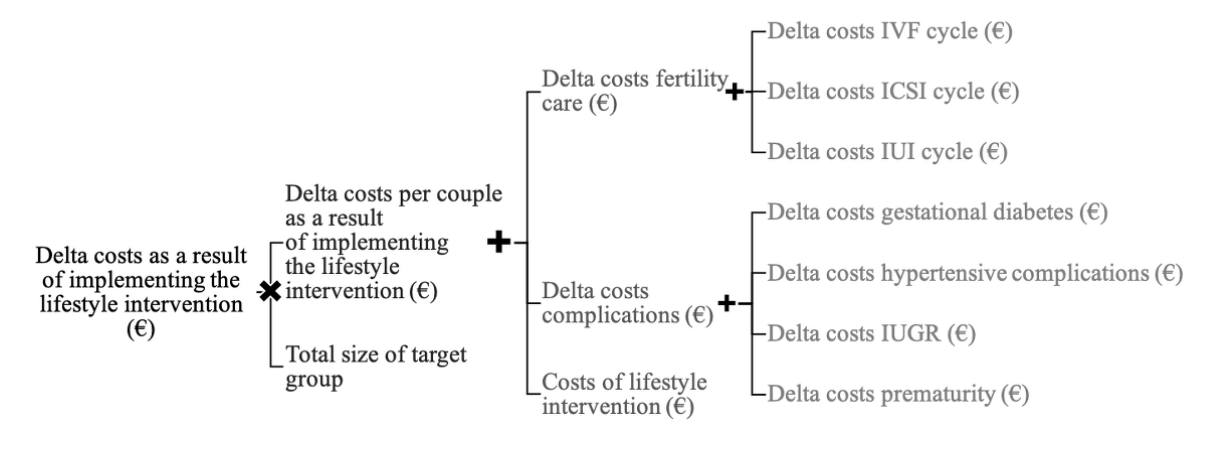
Figure 1. General structure of the cost-effectiveness model for each lifestyle intervention. IUGR: intrauterine growth restriction; IUI: intrauterine insemination; IVF: in vitro fertilization; ICSI: intracytoplasmic sperm